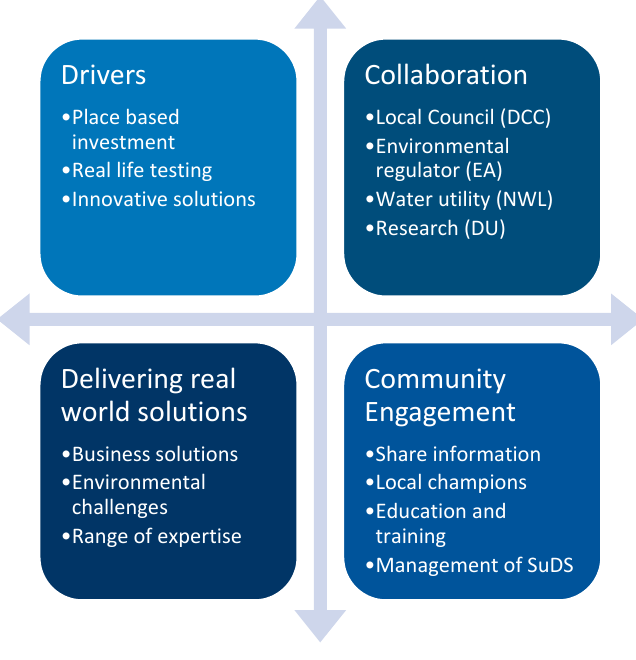
Figure 1. The conceptual framework for the study.